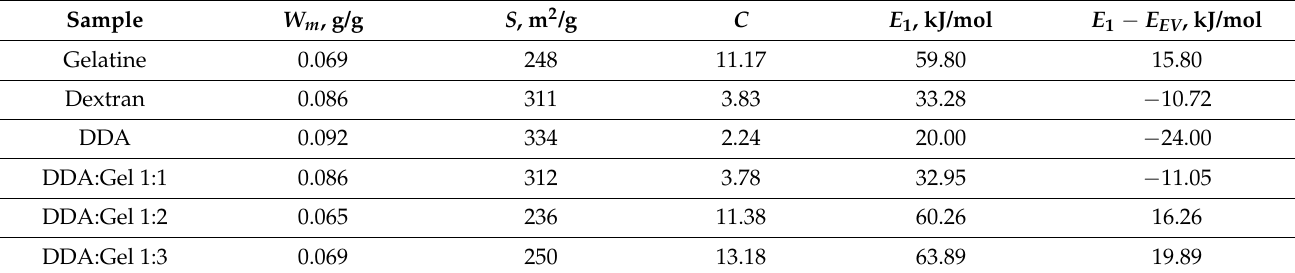
Table 2. Surface characteristics for the investigated samples (BET); ± S.D. did not exceed 3%.